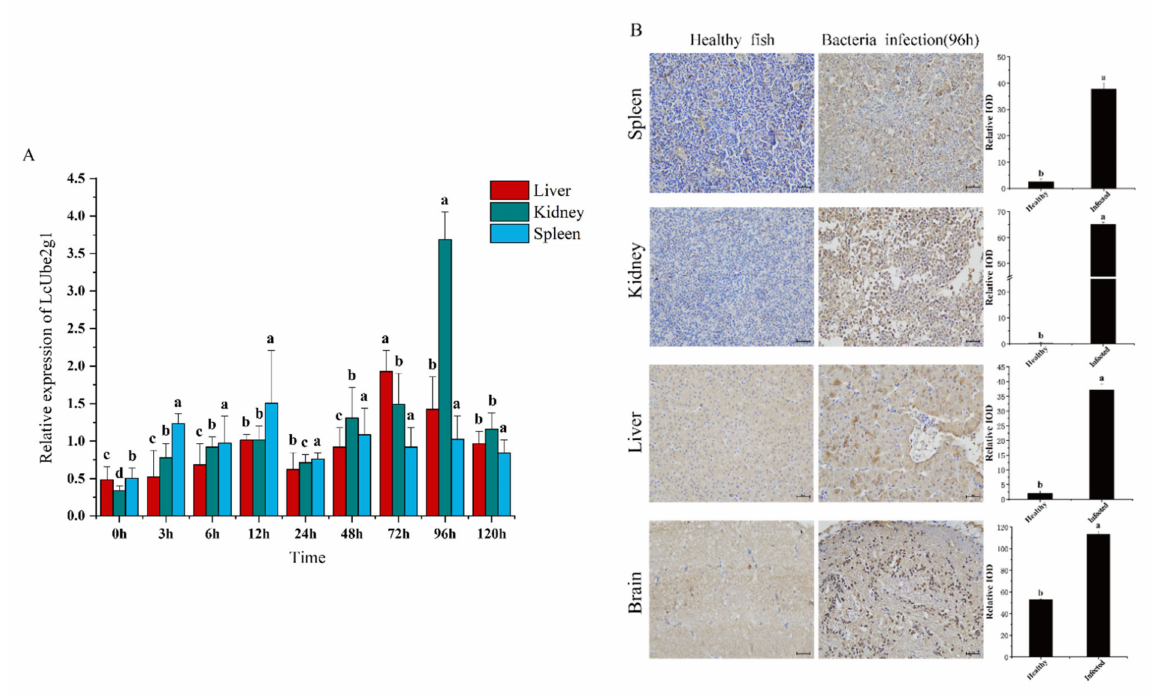
Figure 4. Defense response of UBE2G1 against P.plecoglossicid . ( A ) Time course expression of LcUbe2g1 in different tissues after P.plecoglossicid infection. The relative expression levels of LcUbe2g1 were determined by RT-qPCR in kidney, liver and spleen at 0 h, 3 h, 6 h, 12 h, 24 h, 48 h, 72 h, 96 h and 120 h after P. plecoglossicid challenge. β -actin was used as an internal control. Data are mean ± SE